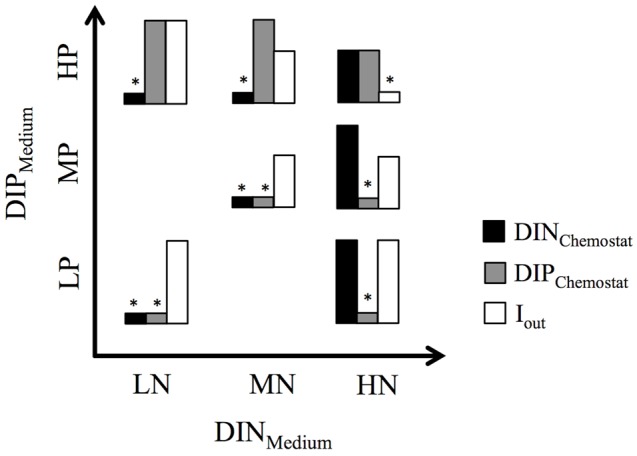
Bar graphs show the relative distribution of nutrient concentrations (DINChemostat, DIPChemostat) and light penetration (Iout) in the seven chemostat experiments. ∗above bars indicate the resulting resource limitation. Experimental set-up is based on three levels of dissolved inorganic nitrogen (DINMedium) and phosphorus (DIPMedium) in the mineral medium supplied to the chemostats.